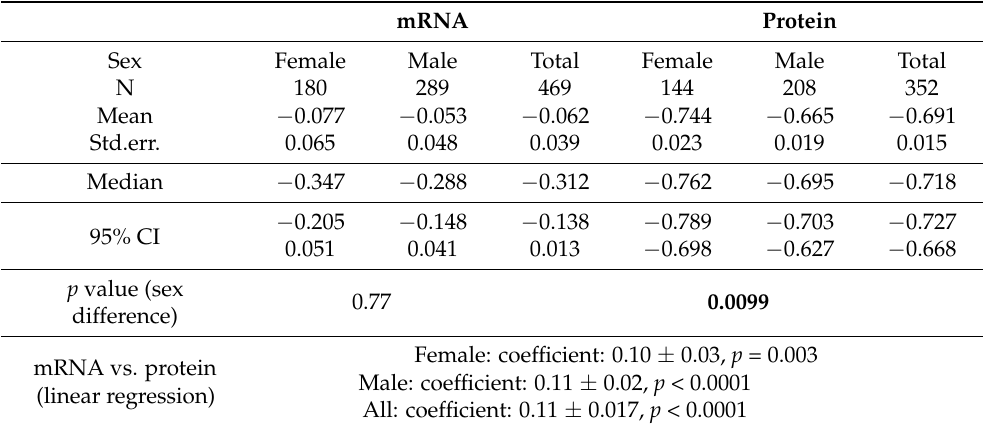
Table 2. The sex difference in AR gene